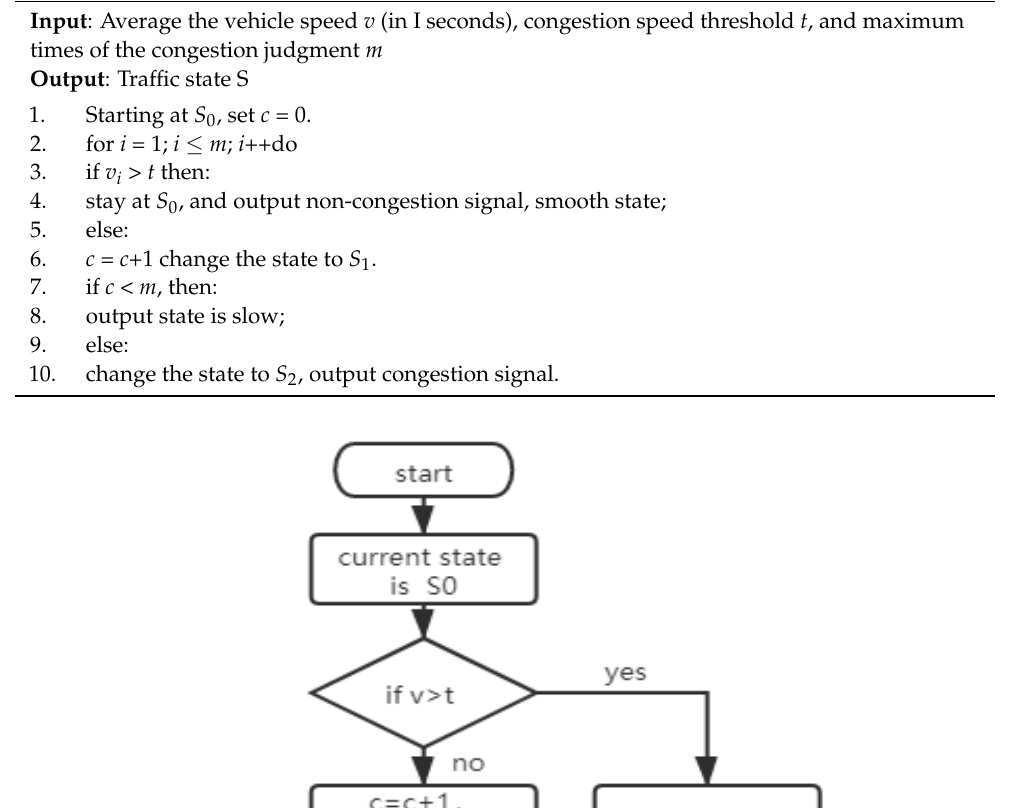
Algorithm 2 Traffic State Discrimination Algorithm.